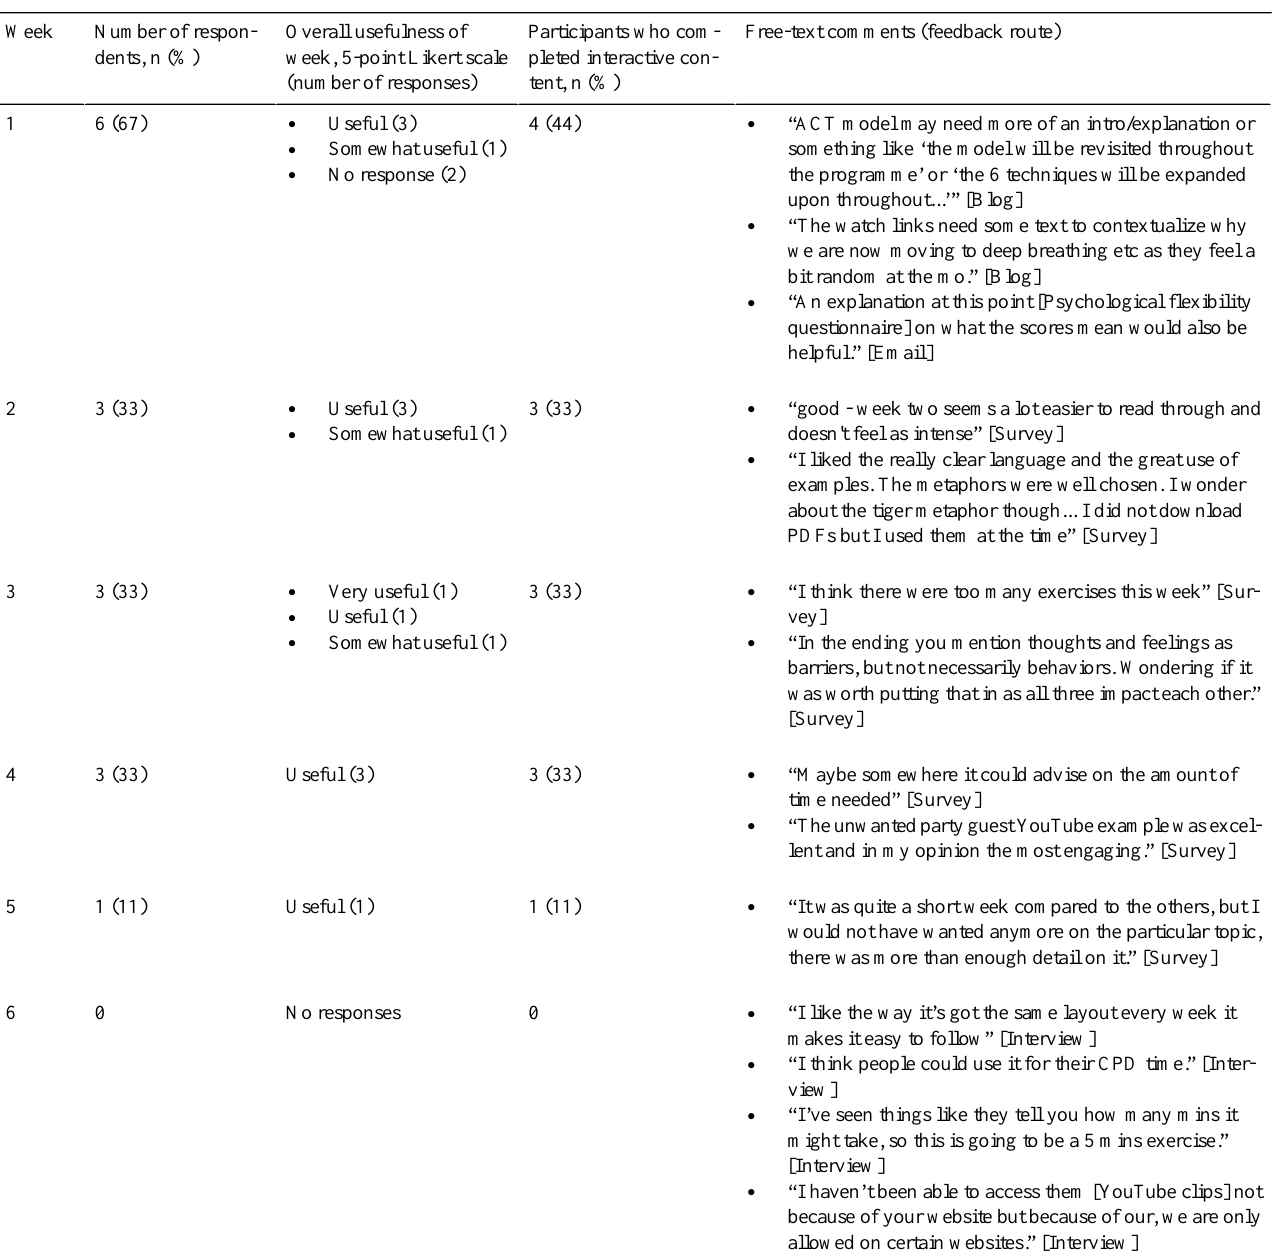
Table 3. Summary of key survey results and free-text